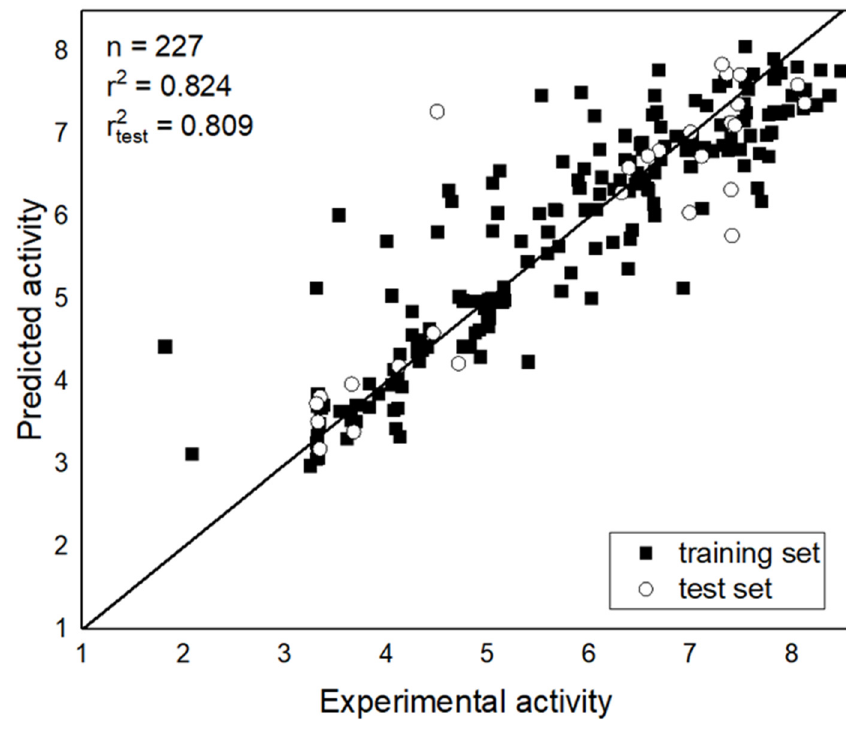
Figure 2. Experimental data versus predicted data from the Topomer CoMFA Model 2.